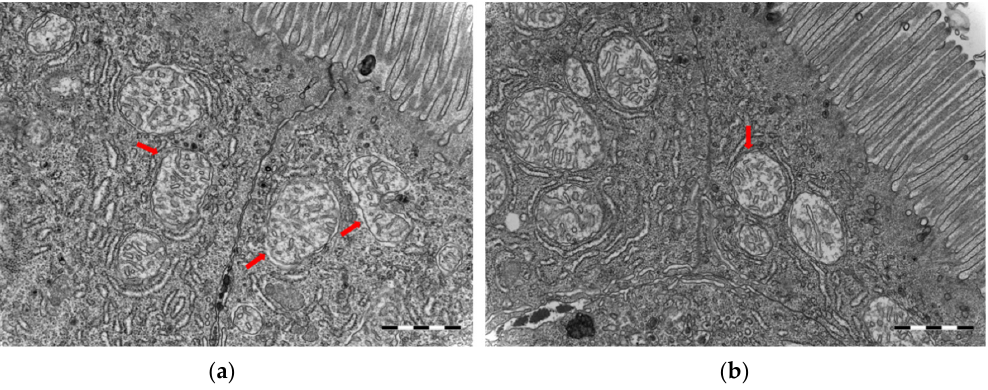
Figure 6. Transmission electron microscopy micrographs of mitochondria from the midgut of cod larvae at 16 dph reared under ( a ) germ-free and ( b ) conventional conditions. ( a ) Mitochondria in germ-free cod larvae were distorted, outer membrane showed discontinuities or was often missing and structures of Christae were reduced or hardly visible. ( b ) Mitochondria in conventional cod larvae showed clear Christae and a double membrane. Scale bars are 1 µm.